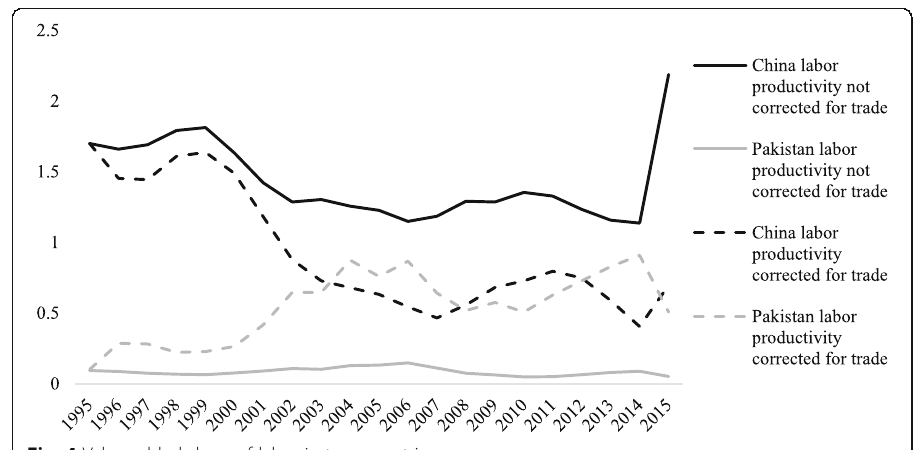
Fig. 4 Value added share of labor in two